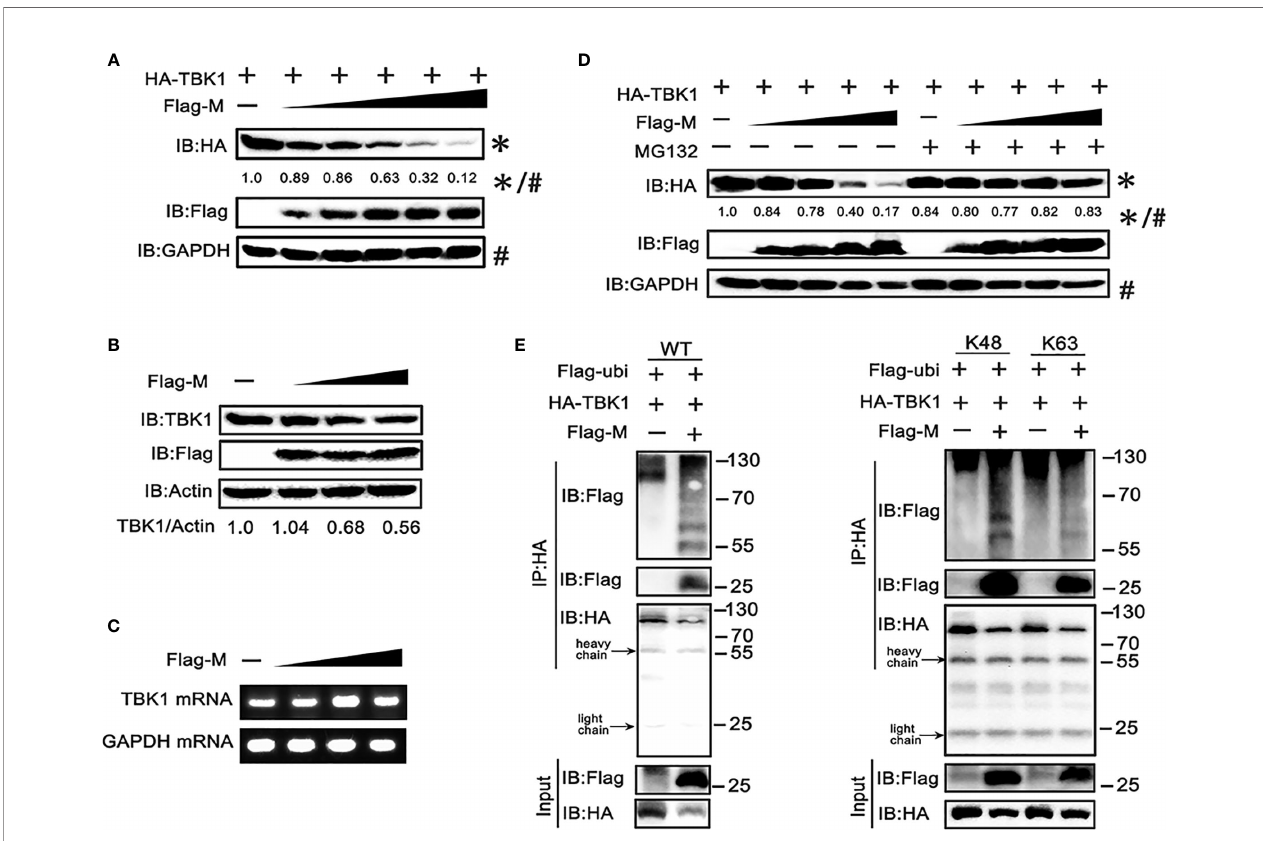
FIGURE 3 | SRAS-CoV-2 M degrades TBK1 via ubiquitination. (A) HEK293T cells in 6-well plate were transfected with a control plasmid or increasing doses of plasmid expressing Flag-M (0.25, 0.5, 1, 2 and 4 m g), along with HA-TBK1 plasmids for 24 h. The cell lysates were analyzed by immunoblot. GAPDH was detected as a loading control. (B) HEK293T cells in 24-well plate were transfected with a control plasmid or increasing doses of Flag-M (0.25, 0.5, 1 m g) for 24 h. The cell lysates were analyzed by immunoblot. Actin was detected as a loading control. (C) HEK293T cells in 24-well plate were transfected with a control plasmid or increasing dose of Flag-M (0.25, 0.5, 1 m g). After 24 h, cells were harvested and mRNA levels of TBK1 genes expression in empty vector or M plasmids transfection groups were analyzed by qPCR. GAPDH was used as a normalizer. (D) HEK293T cells were transfected with a control plasmid or increasing doses of Flag-M and HA-TBK1 plasmids. After 24 h, cells were treated with 20 m M MG132 or DMSO for 6 h. The cell lysates were analyzed by immunoblot. (E) Co-immunoprecipitation and immunoblot analysis of extracts from HEK293T cells transfected with TBK1 with or without SARS-CoV-2 M as well as Flag-Ub (WT, K48-linked, or K63-linked) expression plasmids as indicated. The relative band intensity (*/#) of HA-TBK1 in (A, D) was measured using ImageJ